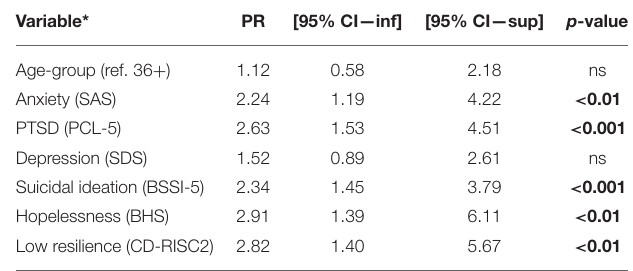
TABLE 4 | Univariate log-binomial regression models for DSH behavior.